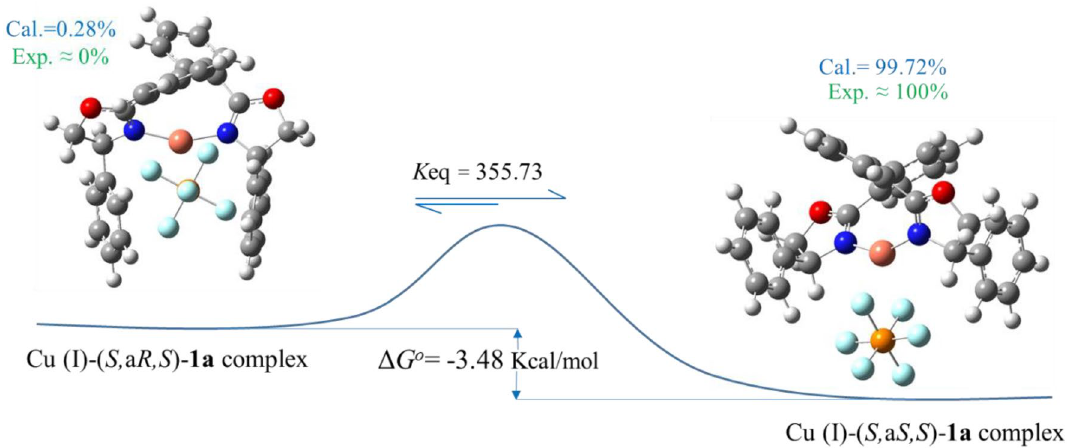
Figure 2. Gibbs free energy and equilibrium constant values for Cu (I)- 1a